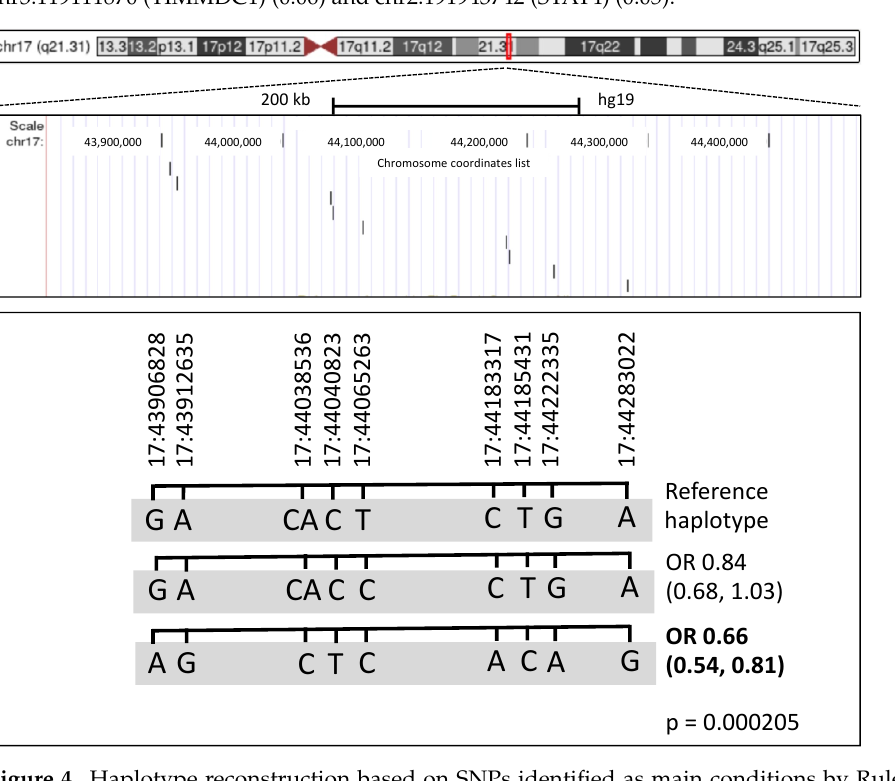
Figure 4. Haplotype reconstruction based on SNPs identified as main conditions by Rulex. The genomic region with position of the 9 SNPs/conditions identified by Rulex. On the top, the ideogram of the entire chromosome 17 is shown; the close-up view indicates the relative positions of the SNPs projected in the lower part of the figure, where haplotypes are listed. Haplotypes were reconstructed using the Plink software; odds ratios (OR) and 95% confidence interval (in parenthesis) were calculated relative to the reference haplotype.